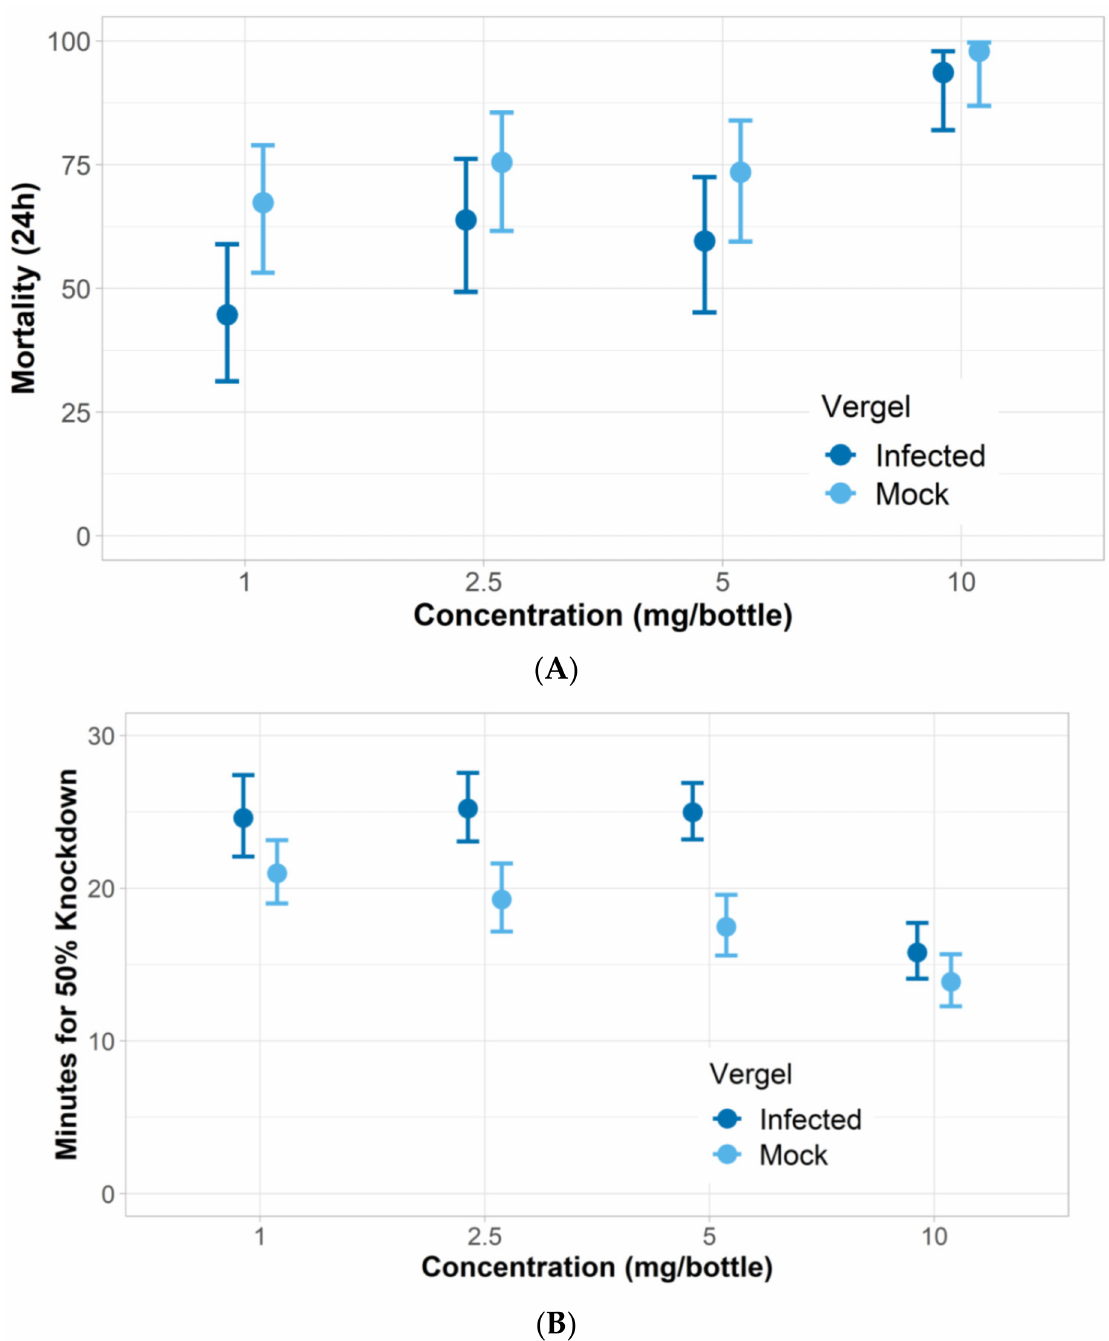
Figure 4. Response of Vergel A. aegypti Zika-infected (infected) and uninfected (mock) mosquitoes when exposed to four concentrations of nootkatone (mg/bottle). ( A ) Mortality at 24 h and, ( B ) 50% of knockdown time in